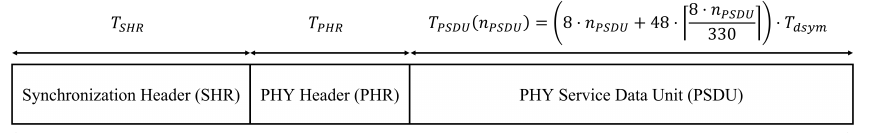
Figure 12. IEEE802.15.4 UWB PHY protocol data unit (PPDU) structure and transmission timing model. The transmission time of PPDU T PPDU is the sum of T SHR , T PHR and T PSDU ( n PSDU ) . n